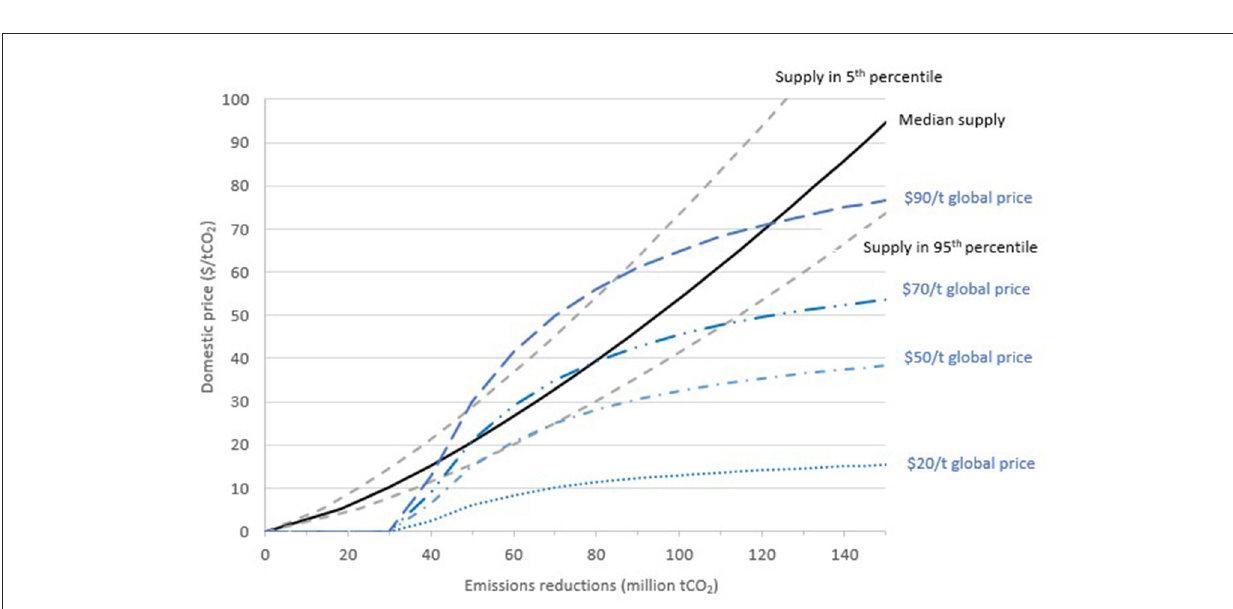
FIGURE4 Abatement supply curve and feasible combinations (in blue) of domestic abatement prices and quantities consistent with the jurisdiction breaking even. Note: Figure combines information shown in Figures 1, 3. For each level of domestic prices paid for abatement, lines in blue denote the minimum quantities of realized abatement that ensure break-even, given the indicated global price for credits. Assumed minimum abatement requirement ( Q ) equals 35 million tCO 2 such that international payments are only made for abatement exceeding that